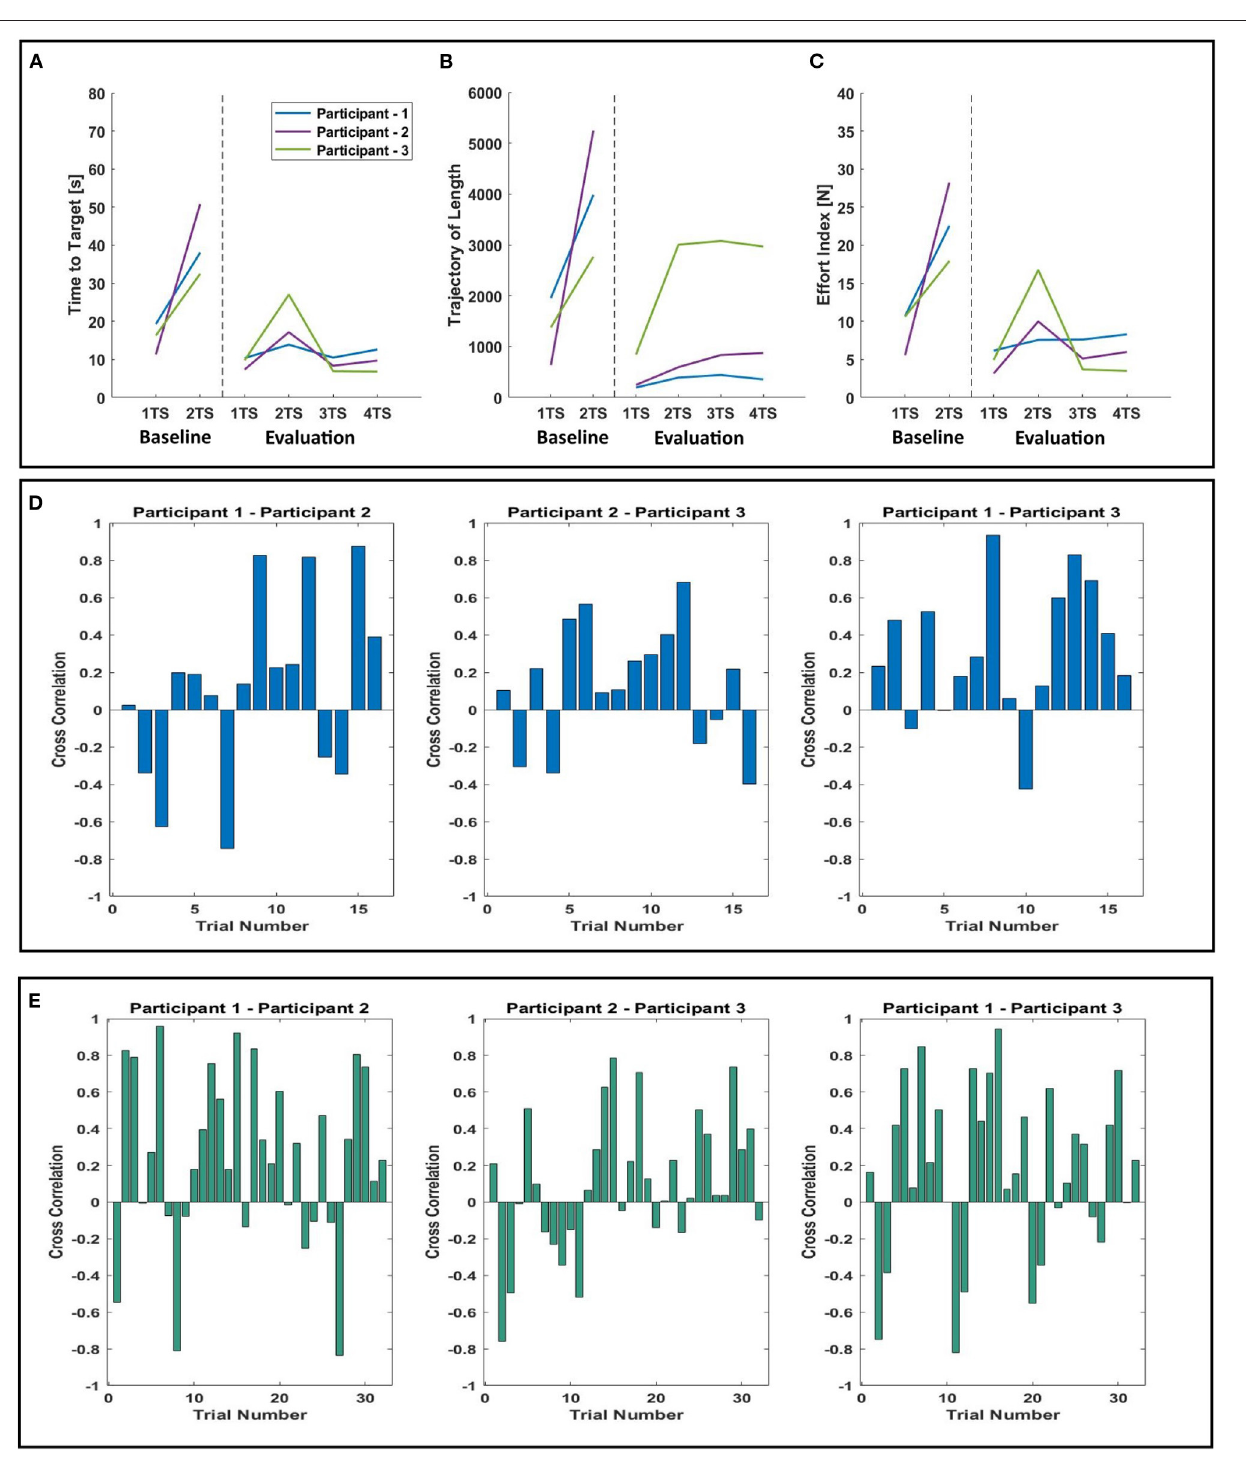
FIGURE 6 | Summary of performance measures of Alone group. (A) Comparison of time to target, (B) comparison of trajectory length, (C) comparison of effort index, (D) cross correlation of trajectories in the Baseline (B-S) phase, (E) cross correlation of trajectories in the Evaluation (E-S) phase.